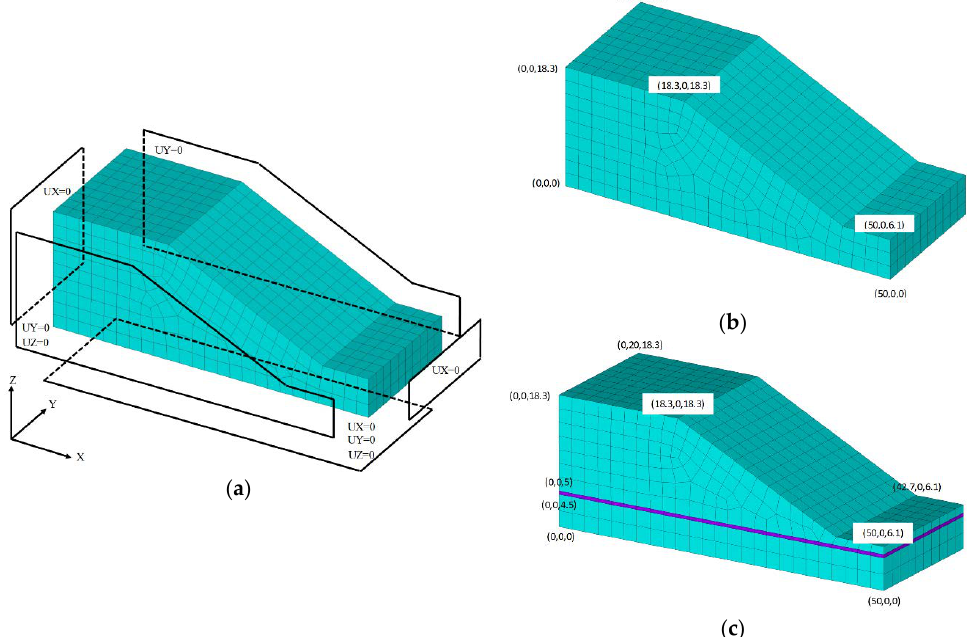
Figure 6. Generic discretized model of the case studies. ( a ) Applied boundary conditions, ( b ) Case 1 and ( c ) Cases 2 and